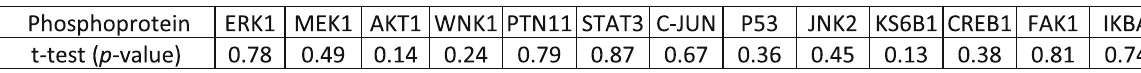
Fig. 3 Basal phosphoprotein profiles of melanoma cell lines. a The phosphorylation status of 13 phospho-proteins was determined in 11 unstimulated melanoma cell lines using xMAP ELISA assays. Bar graphs represent median fluorescent intensity (MFI) analysed from n =3 independently performed experiments (mean+SEM). b Statistical analysis comparing responders (SK-MEL-2, WM115 and WM3211) and non-responders was done using unpaired